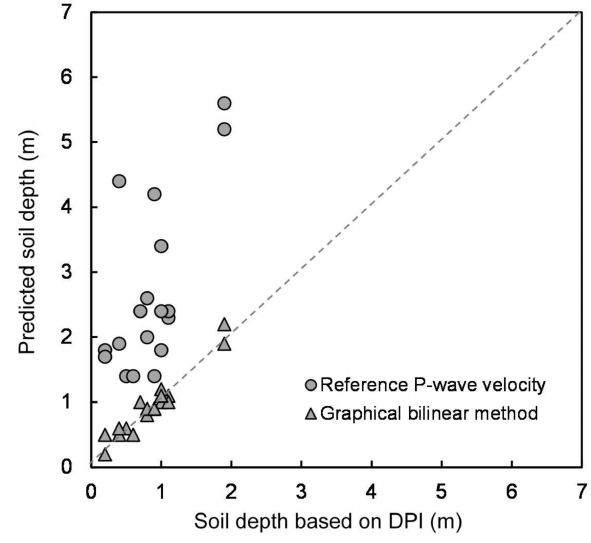
Figure 10. Comparison of soil depths estimated by seismic wave velocity and measured by dynamic cone penetration test.